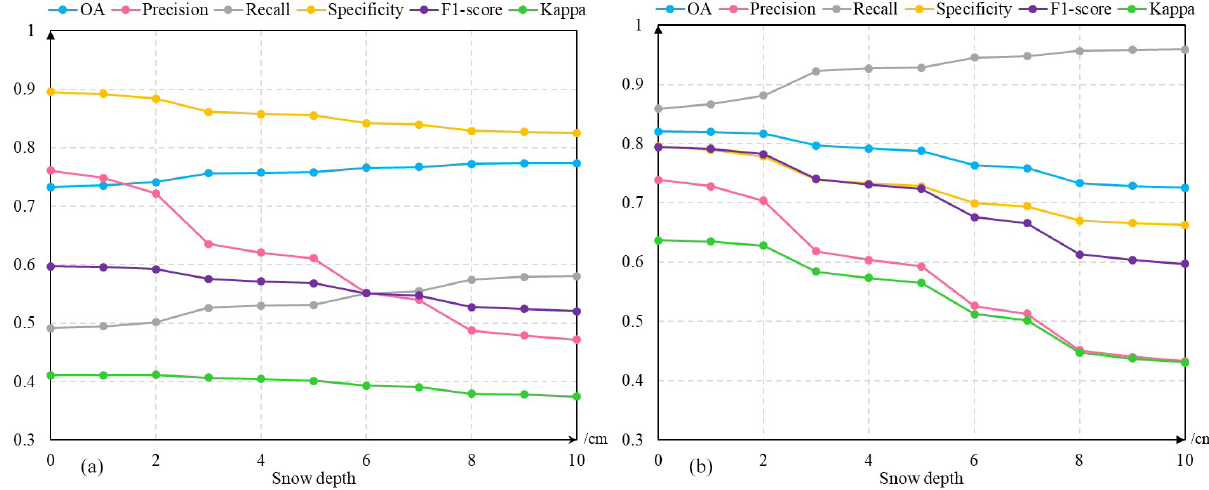
Figure 10. The changes in accuracy indicators (OA, precision, recall, specificity, F1 score, kappa) for snow cover detection are the result of two algorithms ( a : Grody’ algorithm; b : random forest) with increasing in situ snow depth value.